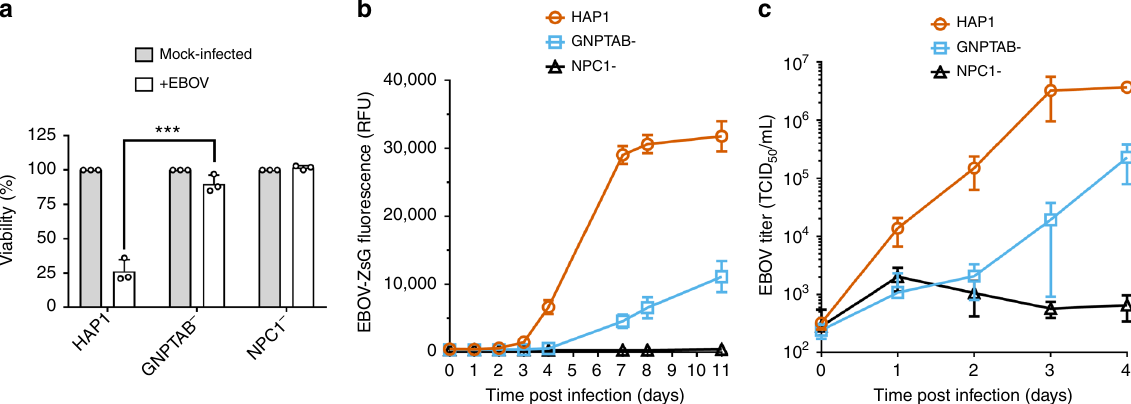
Fig. 2 GNPTAB is required for ef fi cient EBOV infection. a GNPTAB − cells survive EBOV infection. Parental HAP1, GNPTAB − , or NPC1 − knockout cells were infected with wild-type EBOV at an MOI of 0.3, and viability relative to mock-infected cells was determined 6 days p.i. Data represent the mean ± s.d. of three independent experiments. Statistical analysis was performed with a two-tailed Student ’ s t -test, with signi fi cance shown as ***, P = 0.0005. b Infection with the EBOV-ZsG reporter virus is reduced in GNPTAB − knockout cells. Parental HAP1 (orange circles), GNPTAB − knockout (blue squares) and NPC1 − knockout (black triangles) cells were infected with EBOV-ZsG at an MOI of 0.1 and ZsG fl uorescence was measured over time. Data represent the mean ± s.d. of 4 biological replicates. A representative of three independent experiments is shown. c Wild-type EBOV growth is impaired in GNPTAB − knockout cells. Parental and knockout HAP1 cells were infected with wild-type EBOV at an MOI of 0.5. Samples of culture supernatant were taken at intervals and the EBOV titer was determined. Data represent the mean ± s.d. of three biological replicates. A representative of two independent experiments is shown